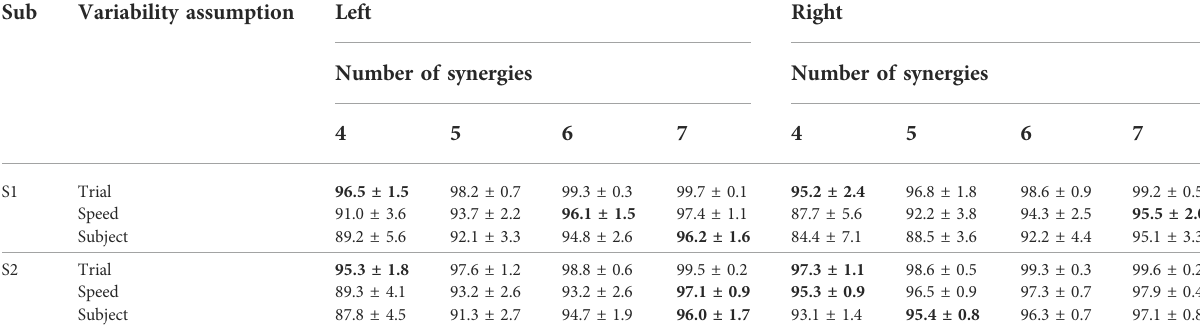
TABLE 3 Mean ± standard deviation of VAF values for the reconstruction of measured muscle excitations with muscle synergy analysis across both subjects and all calibration trials with four to seven synergies when unmeasured synergy vector weights were assumed to be trial-speci fi c, speed speci fi c, or subject-speci fi